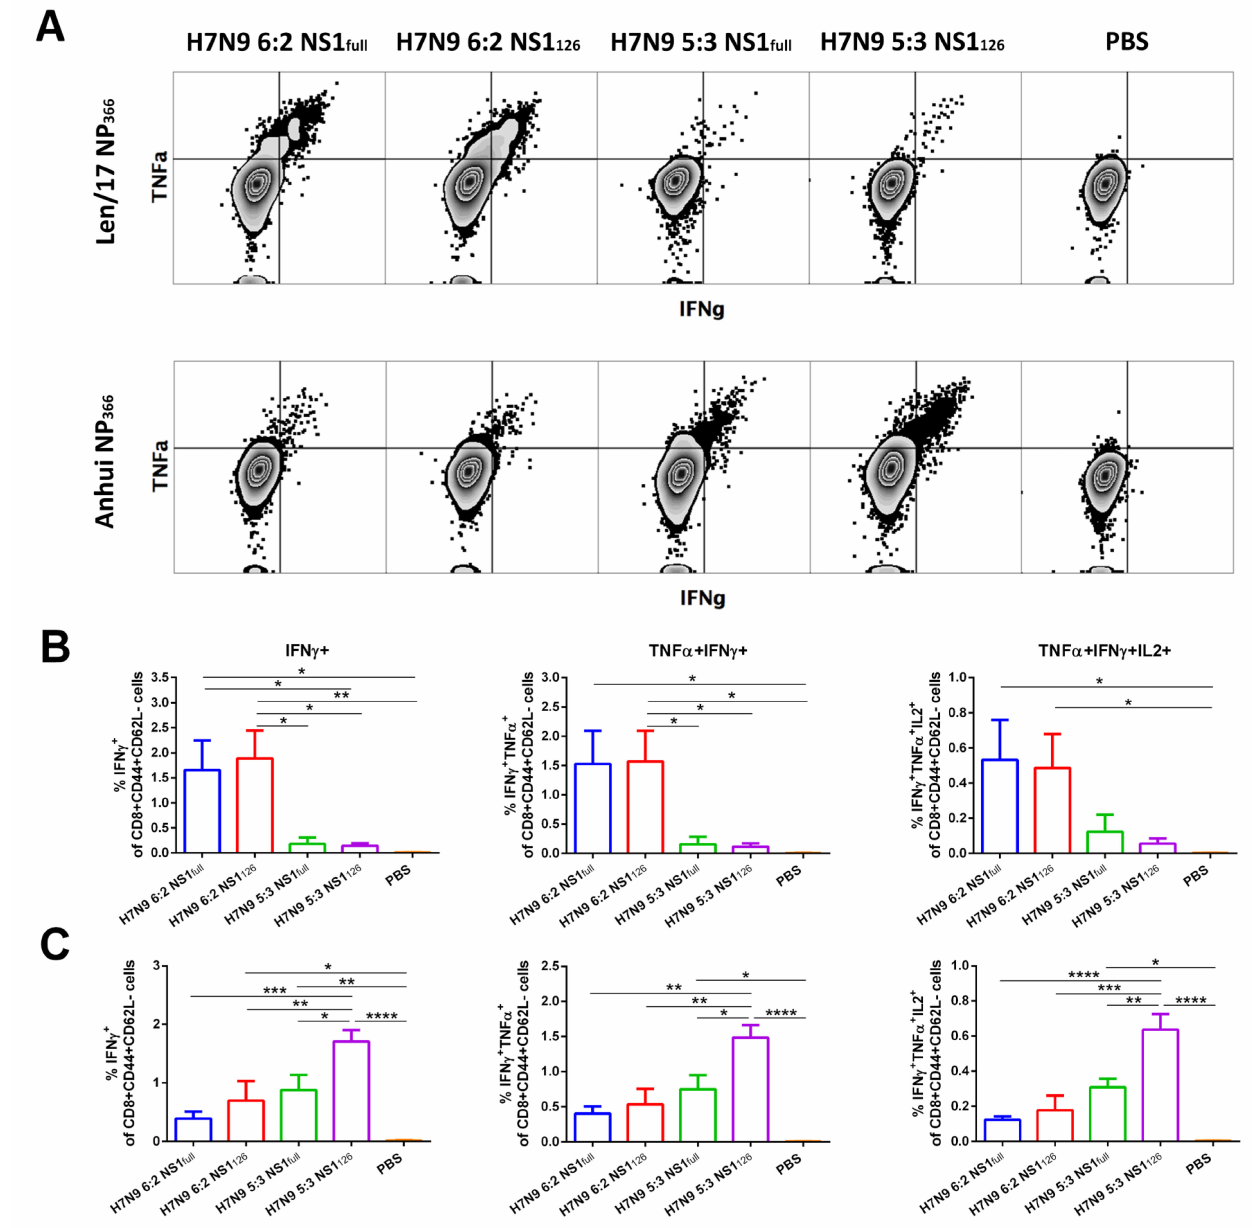
Figure 4. Systemic NP 366 -specific effector memory CD8+ T-cell responses, measured in mouse spleen on day 7 after the second immunization. ( A ) Representative flow cytometry plots for IFN γ and TNF α expression by Tem cells after stimulation with Len/17 or Anhui NP 366 peptides. ( B ) Levels of CD8+ Tem cells expressing IFN γ only, IFN γ and TNF α or IFN γ , TNF α and IL-2 cytokines in response to stimulation with Len/17 NP 366 peptide (ASNENMDTM). ( C ) Levels of CD8+ Tem cells